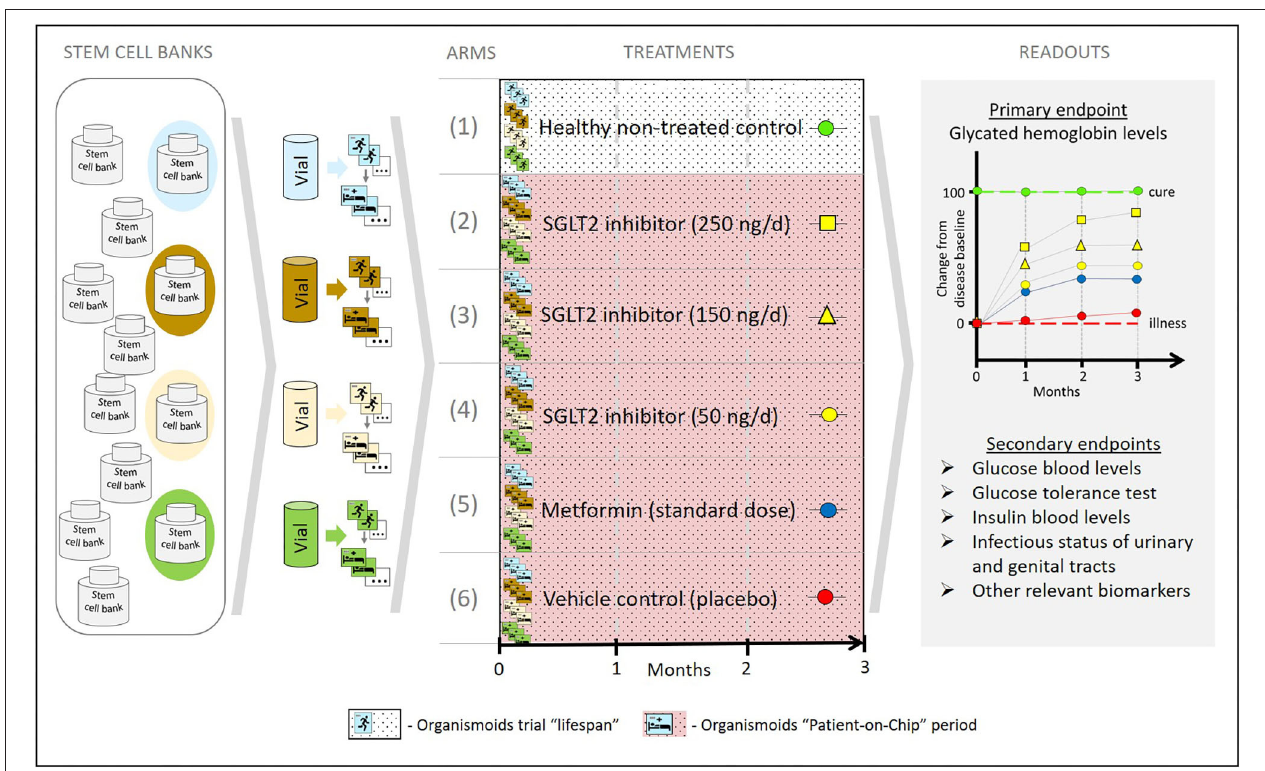
FIGURE 7 | A hypothetical example illustrating how the organismoid theory can be utilized to emulate clinical